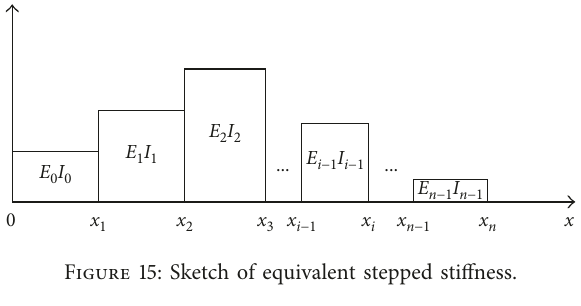
Figure 15: Sketch of equivalent stepped stiffness.